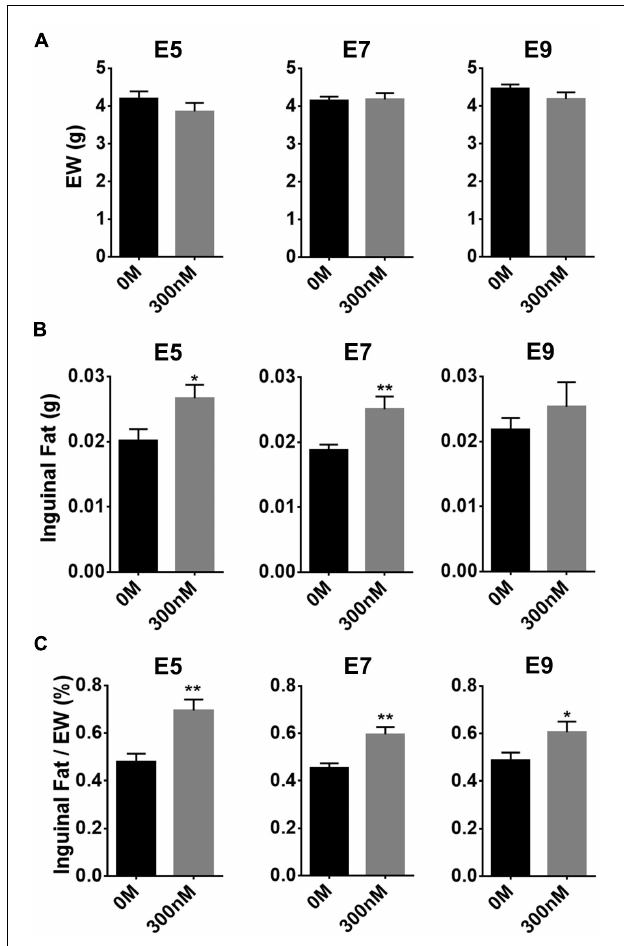
FIGURE 3 | Effect of time of in ovo all- trans retinoic acid (atRA) injection. Embryo weight (EW) (A) , inguinal fat pad weights (B) , and percentages of weights of inguinal fat tissues in EW (C) . Both 0-M and 300-nM concentrations of atRA were injected in ovo at embryonic day (E) 5, E7, or E9; and injected embryos were sampled at E14. For 0 M or 300 nM of atRA, n = 8 and n = 8 embryos at E5, n = 9 and n = 8 embryos at E7, and n = 11 and n = 12 embryos at E9, respectively. All data were expressed as means ± SEM. The data were analyzed by a Student t -test using GraphPad Prism software, version 6.02. * p < 0.05, ** p <